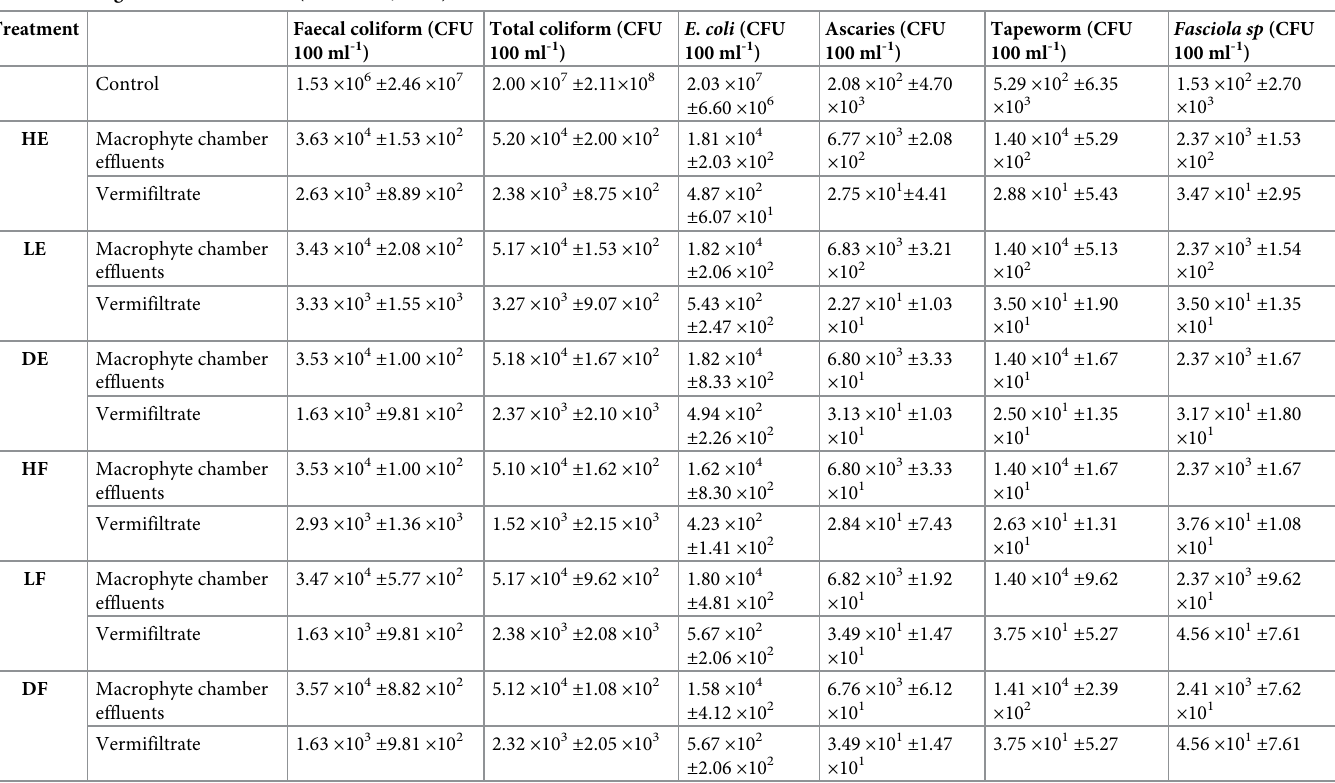
Table 2. Pathogen count in effluents (mean ± S.D; n = 3).